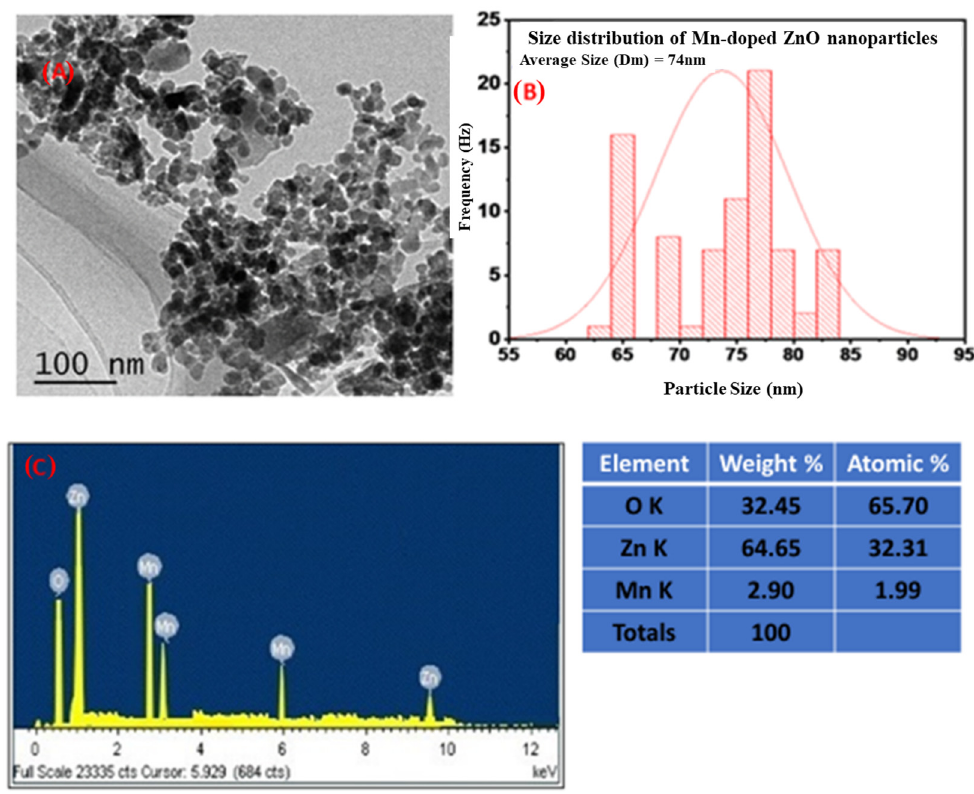
Figure 2. TEM image of Mn-ZnO nanoparticles. ( A ) Size distribution of Mn-ZnO nanoparticles, showing the average particle sizes of nanoparticles. ( B ) EDX pattern of Mn-ZnO, showing the purity of the sample ( C ).